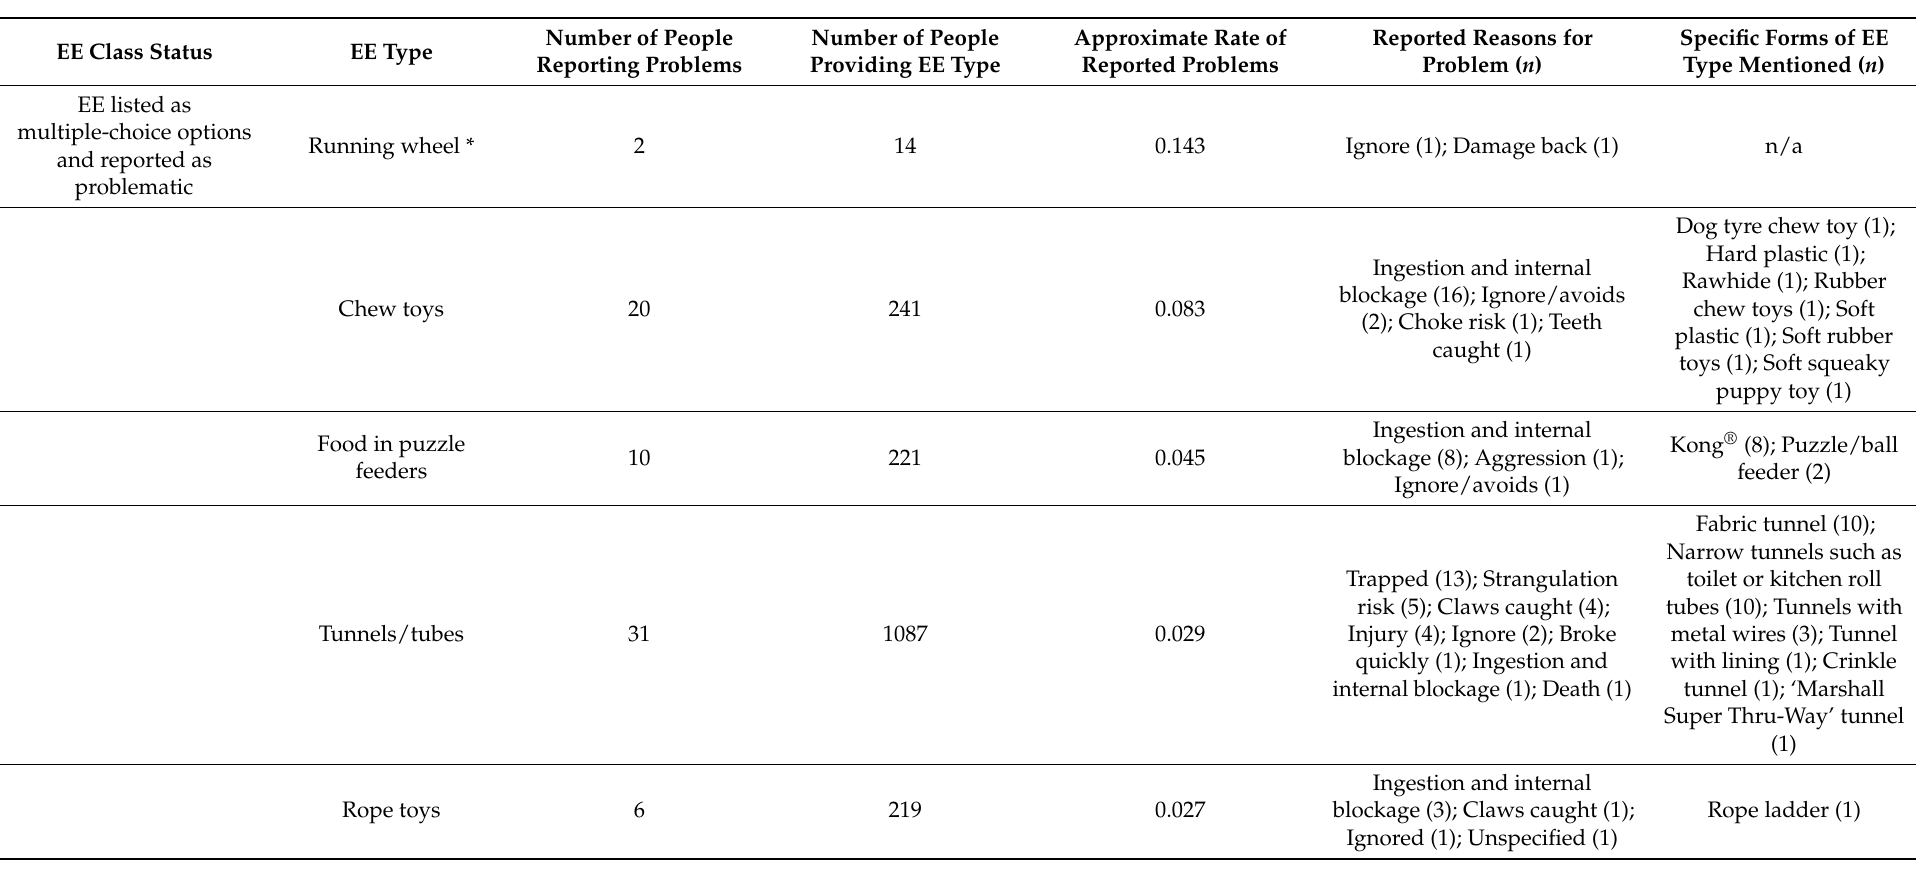
Table 5. Environmental enrichment (EE) types which caretakers reported as being problematic, either due to risk to ferrets, ferrets ignoring or rarely using the EE, or due to the EE being quickly and easily destroyed (financially impractical). EE types are listed in order from EE type with the highest approximate rate of reported problems to the fewest. Reasons given for the EE type being problematic are listed with the number of respondents reporting the reason shown in brackets. If any specific types of EE were mentioned in relation to the EE type these are also listed alongside the number of respondents reporting the item in